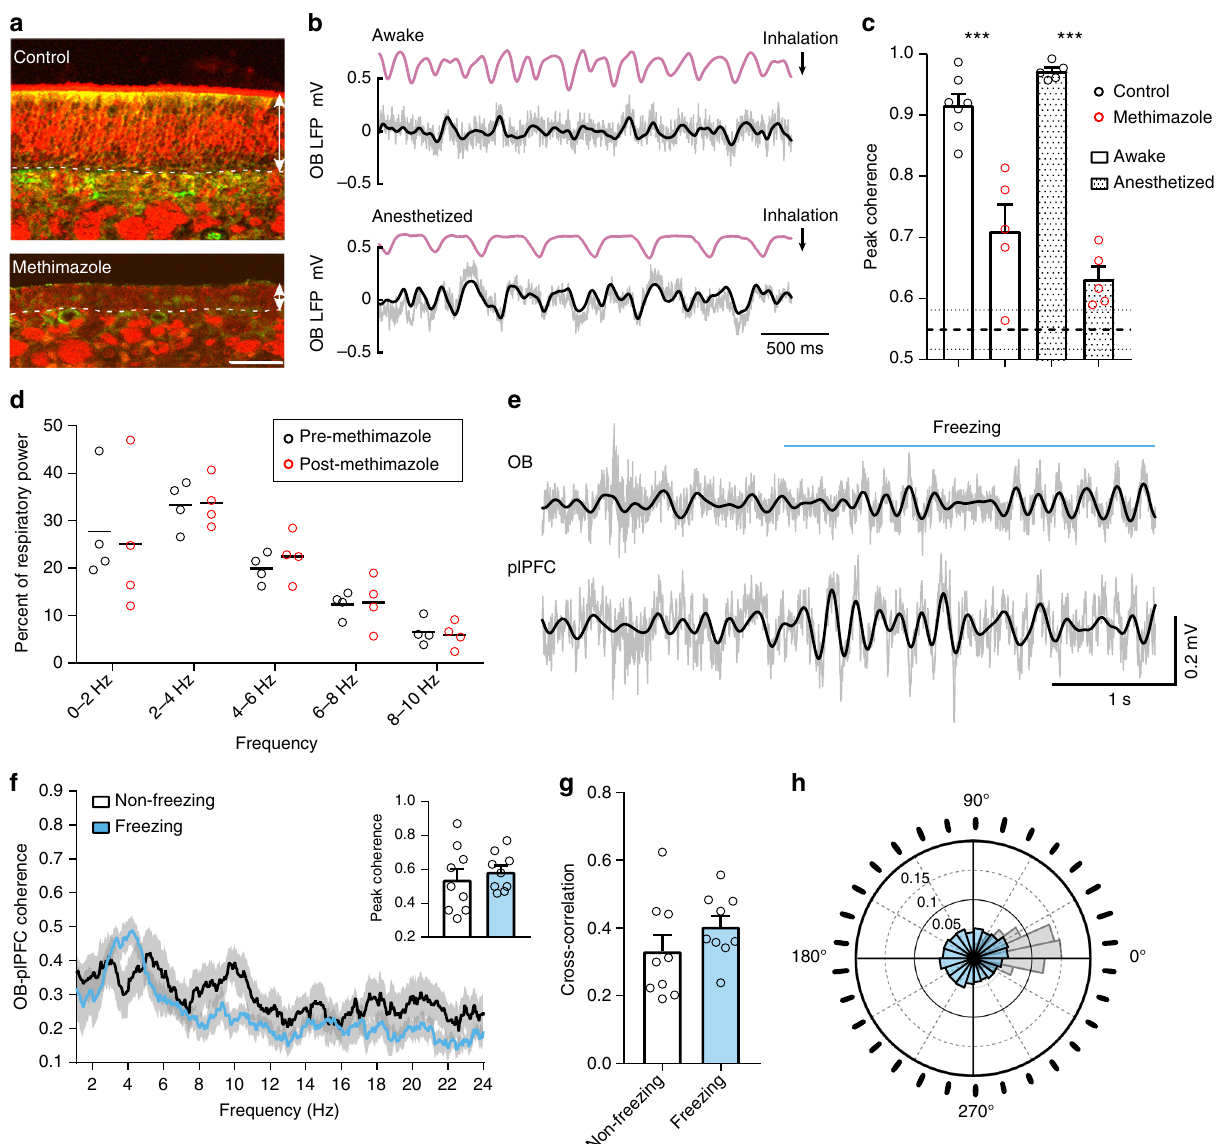
Fig. 5 Disruption of olfactory inputs decouples OB LFPs from respiration during freezing. a Sections of olfactory epithelia from six-week-old mice. Arrow lines denote the thickness of the olfactory epithelium. Dashed lines mark the basement membrane that separates the olfactory epithelium from the underneath lamina propria. Asterisks mark OMP + axonal bundles. Scale bar: 50 µ m. b Thermocouple and OB LFP recordings from a single mouse following methimazole injection. The OB oscillations no longer faithfully follow respiration, in contrast to control condition (c.f. Fig. 1b top). c Average peak coherence between respiratory signals and OB LFPs (one-way ANOVA F (3,17) = 35.1, Tukey post hoc, awake control vs methimazole, p < 0.001; anesthetized control vs methimazole, p < 0.001). The average peak coherence between respiration and shuf fl ed OB signals is 0.55, indicated by the thick dashed line (the two thin dashed lines indicate the standard errors). d The percent of power in 5 frequency bands of respiration recorded in awake, behaving mice ( n = 4) is unchanged following methimazole treatment. Respiratory signals (2 hr) were recorded pre and post methimazole injection in the home cage and analyzed in 10 s epochs. e Example OB and plPFC LFPs during a freezing epoch in a methimazole treated mouse. Filtered signals (2 – 6 Hz) are overlaid on raw traces (gray). f Spectral coherence between simultaneously recorded OB and plPFC LFPs during non-freezing baseline (black) and freezing (blue) periods (mean ± SEM, n = 9 mice). Inset, averaged peak coherence for non-freezing and freezing periods (0.54 ± 0.06 to 0.58 ± 0.04, n = 9, paired two-tailed Student ’ s t test t (8) = 0.552, p = 0.596). g Maximum OB-plPFC cross-correlation values during non-freezing and freezing periods (0.33 ± 0. 05 to 0.40 ± 0.03, n = 9, paired two-tailed Student ’ s t test t (8) = 1.078, p = 0.313). h Circular distribution of phase differences between OB and plPFC 2 – 6 Hz signals during freezing (Rayleigh test for circular non uniformity z = 2.08, p = 0.125). Data from methimazole treated animals are overlaid on the distribution from control animals (in gray as in Fig.